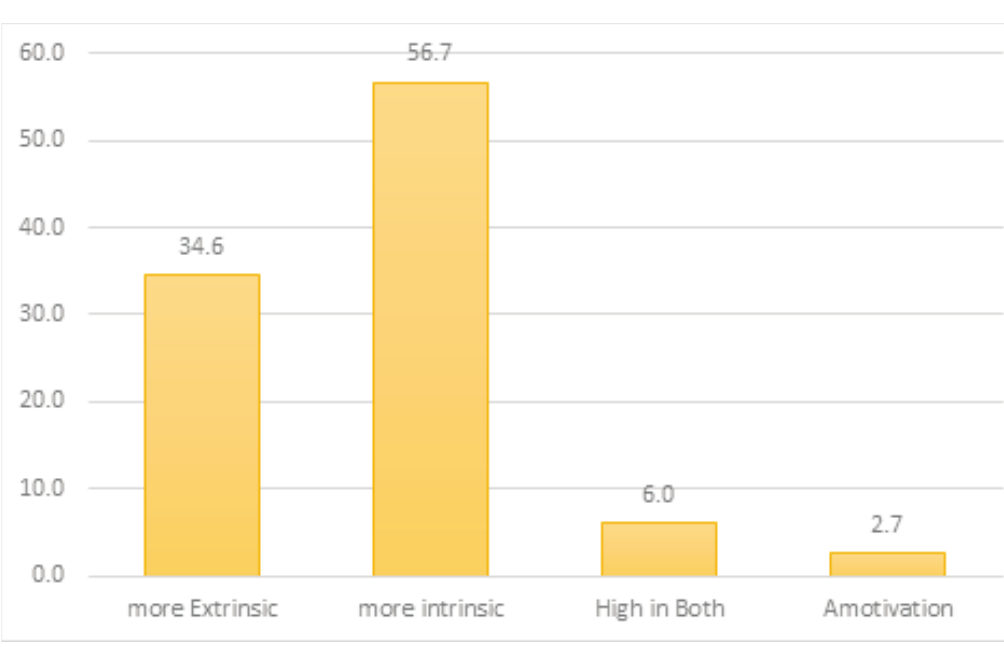
Figure 1: Quality of motivation in first-year medical students of the University of Khartoum toward community medicine